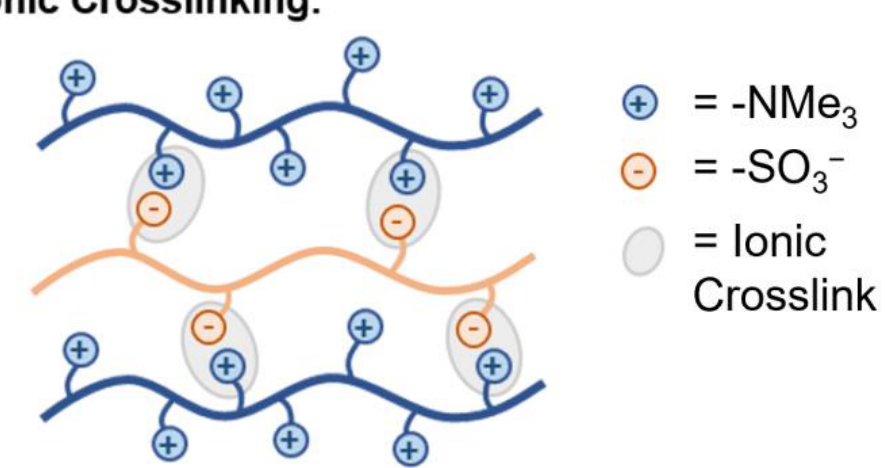
Figure 18. Illustrative depiction of blended ionic crosslinked AAEM.